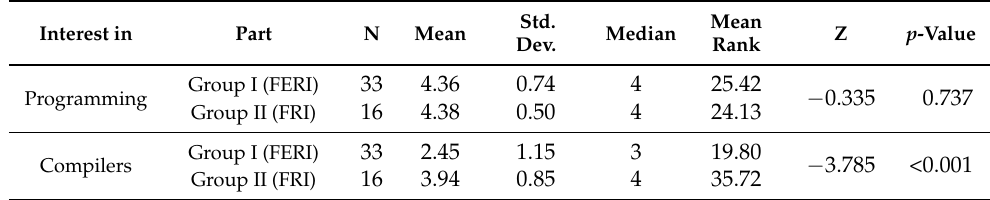
Table 2. Background study on interest (Mann–Whitney